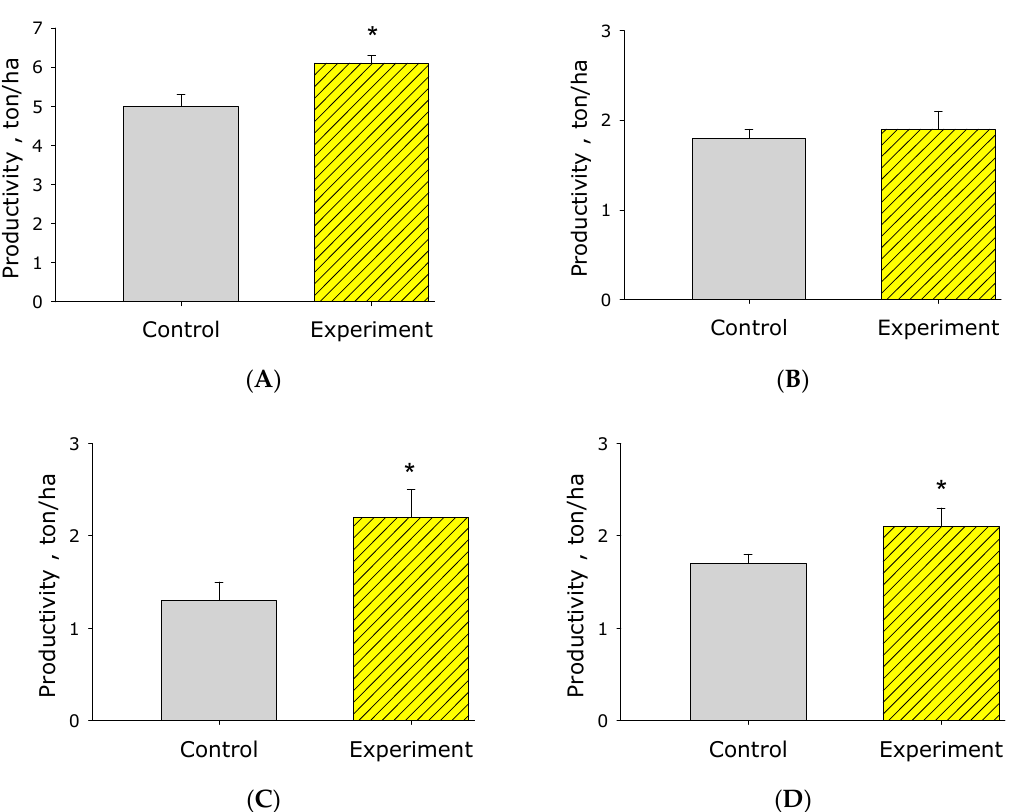
Figure 4. Histogram of the main results of the analysis of sheaves of biomass of grain sorghum “Eltonskoye” soaked in activated water (Experiment) and control water (Control). ( A )—terrestrial biomass, ton/hectare; ( B )—biomass of stubble 15 cm high, ton/hectare; ( C )—hay biomass, ton/hectare; ( D )—biomass of grain, ton/hectare. *—statistical differences relative to control ( p < 0.05).